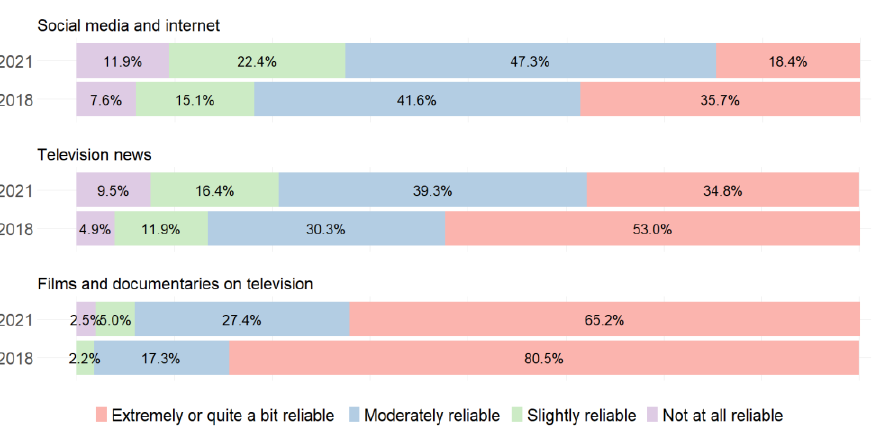
Figure 1. Perceived reliability of information sources in the 2018 and 2021 survey question “How reliable do you consider the following information sources to be?” Only information sources for which perceived reliability was significantly different between the two surveys are shown.